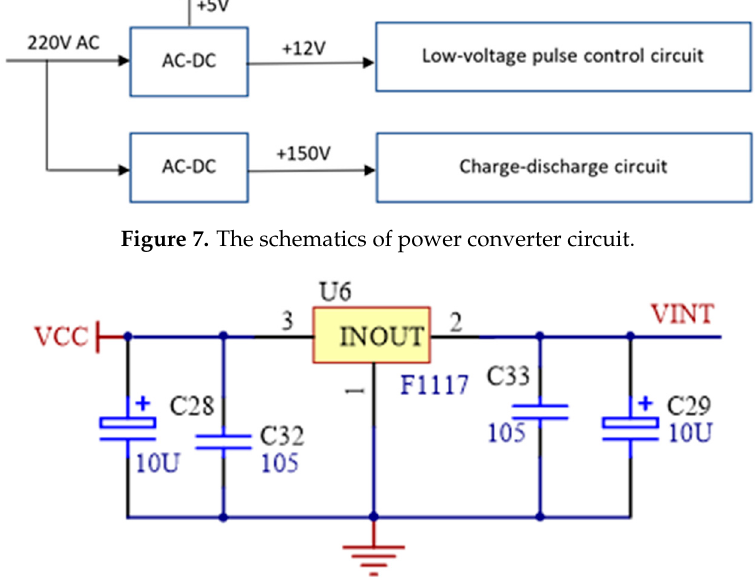
Figure 8. The schematics of regulator.